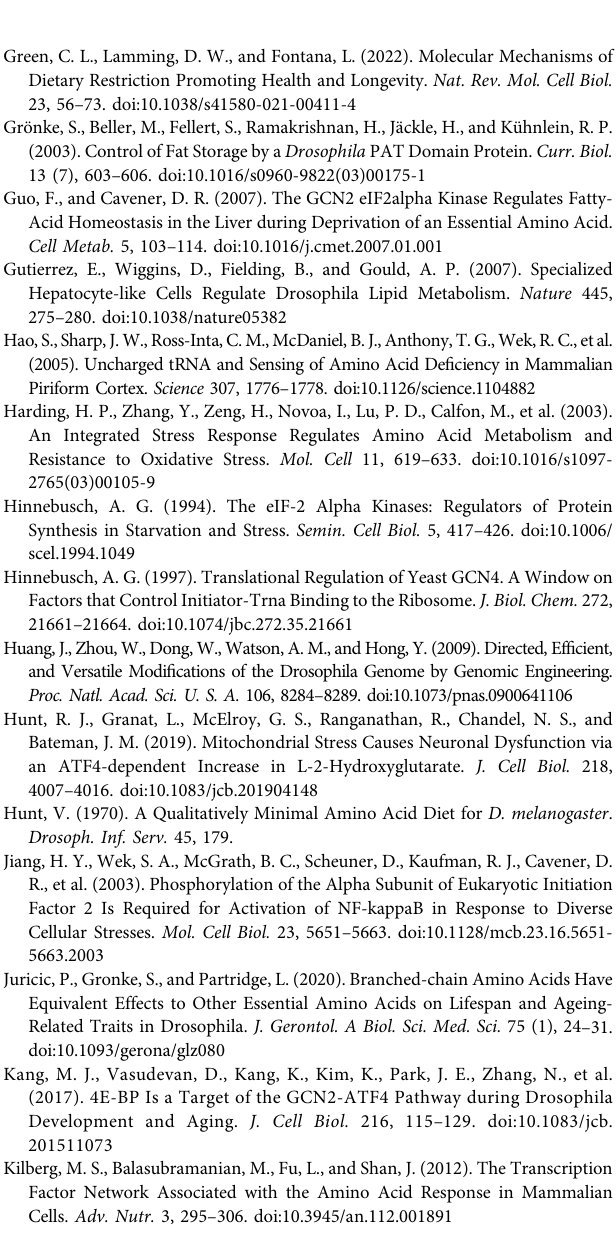
representation of GCN2 dependent genes overlapping with ATF4-target genes. No signi fi cant overlap was detected by Fisher ’ s exact test. (D) Expression level of ASNS in w Dah controls and Gcn2 1 mutants on each diet based on the RNA Seq